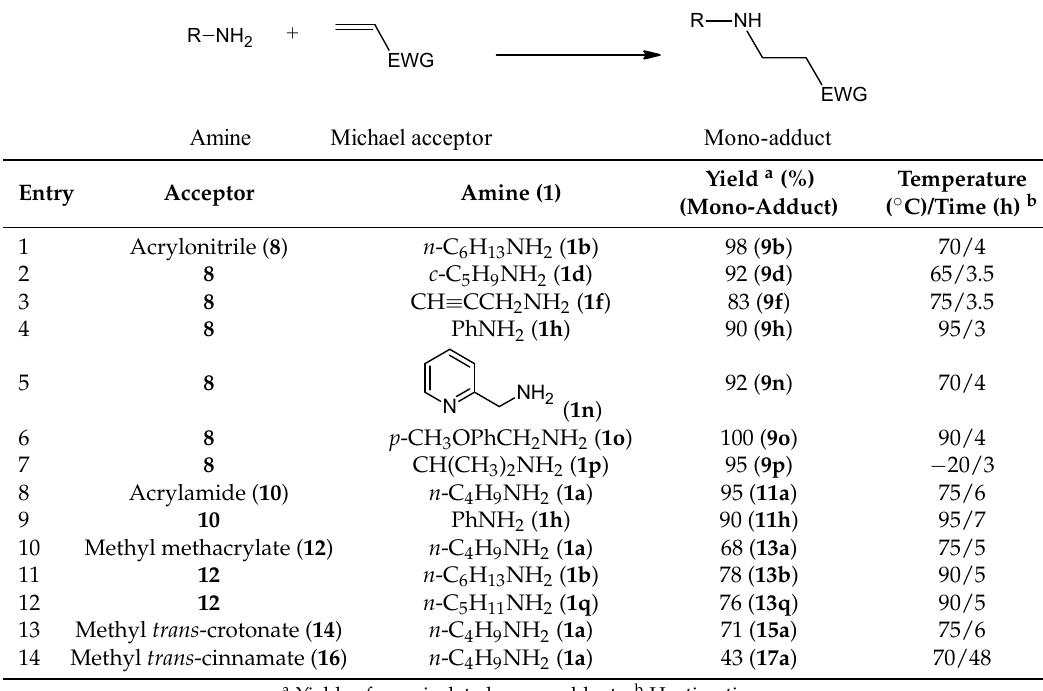
Table 3. Yields and conditions for mono-addition of various amines with different Michael acceptors.